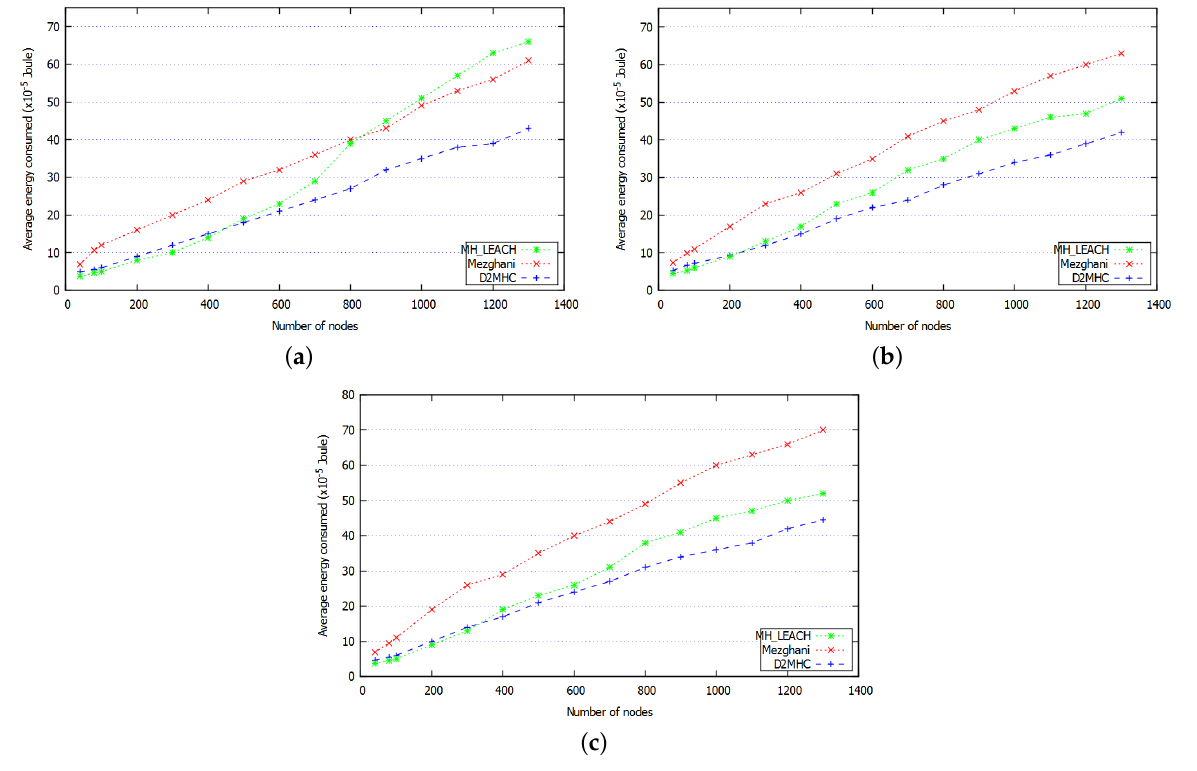
Figure 13. Average energy consumption of the three approaches with ( a ) k = 1, ( b ) k = 2, ( c ) k = 3. Table 6. Synthesis of energy consumption gains compared with Mezghani and